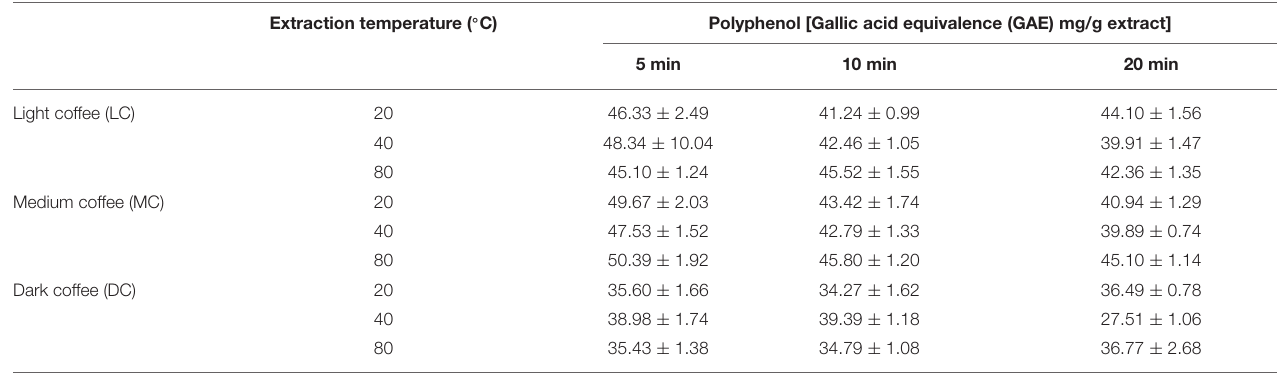
TABLE 4 | Total polyphenol content of coffee roast extracts according to the extraction temperature and